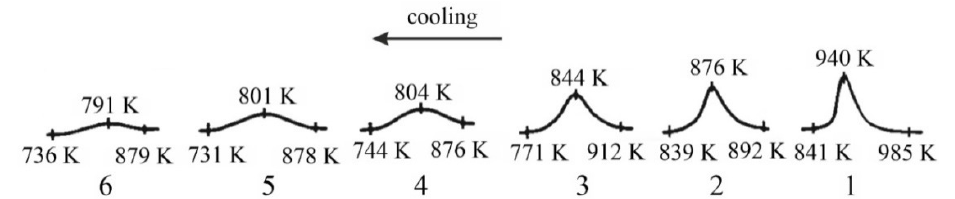
Figure 11. Thermograms recorded for samples 1-6 during the cooling process, showing the temper- ature of the polymorphic transition from α ‘ L -C 2 S to β -C 2 S.